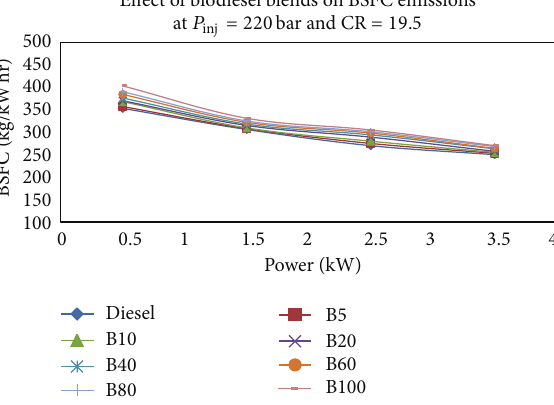
Figure 25: Variation in BSFC for various biodiesel blends at 𝑃 220 bar and CR 19.5.